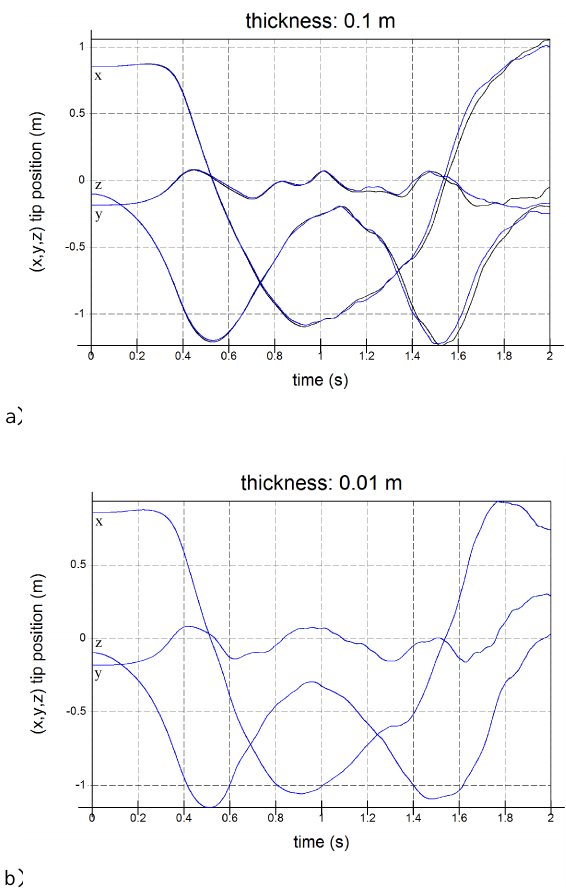
Figure 10. Trajectories of the tip of the double pendulum in Fig. 10. Trajectories of the tip of the double pendulum in Test A Test A (a) and in Test B (b) in Sect. 6.8. For each of the two (a) and in Test B (b) in Sect. 6.8. For each of the two tests either tests either two simulations are performed: one by using an FE- two simulations are performed: One by using an FE-discretization discretization with 32 Bernoulli–Euler Finite Elements (3 blue curves for x , y , and z position components), and another by using with 32 Bernoulli-Euler Finite Elements (3 blue curves for x, y, and 32 Timoshenko beam finite elements (3 black curves). The three z position components), and another by using 32 Timoshenko beam black curves cannot be seen in Plot (b) , since the blue curves are on finite elements (3 black curves). The three black curves cannot be top of them. In other words, the FE-solutions converge as the ratio seen in Plot (b), since the blue curves are on top of them. In other of thickness to length goes to words, the FE-solutions converge as the ratio of thickness to length goes to zero.